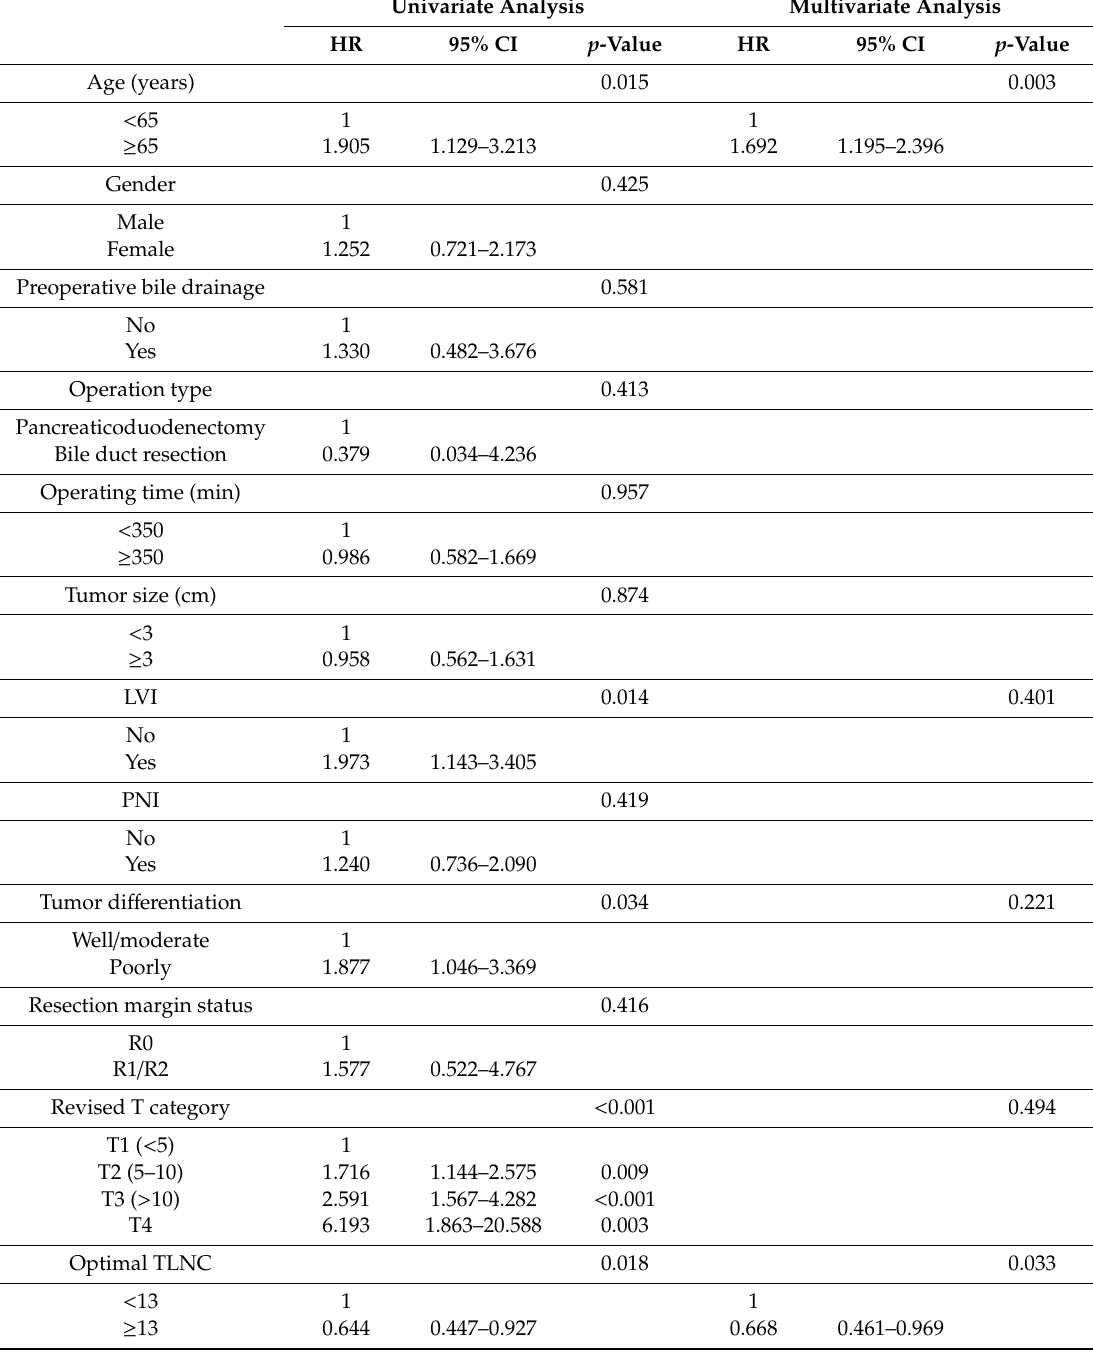
Table 4. Univariate and multivariate analysis of risk factor for overall survival rate (OSR). Univariate Analysis Multivariate